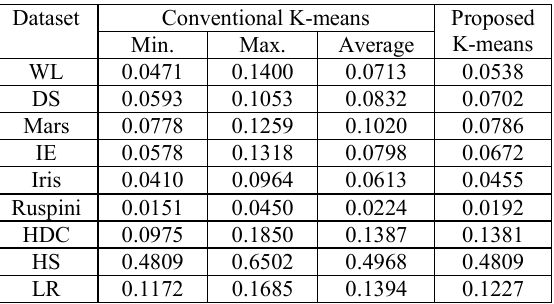
Table 2. Error estimation indexes for all datasets Dataset